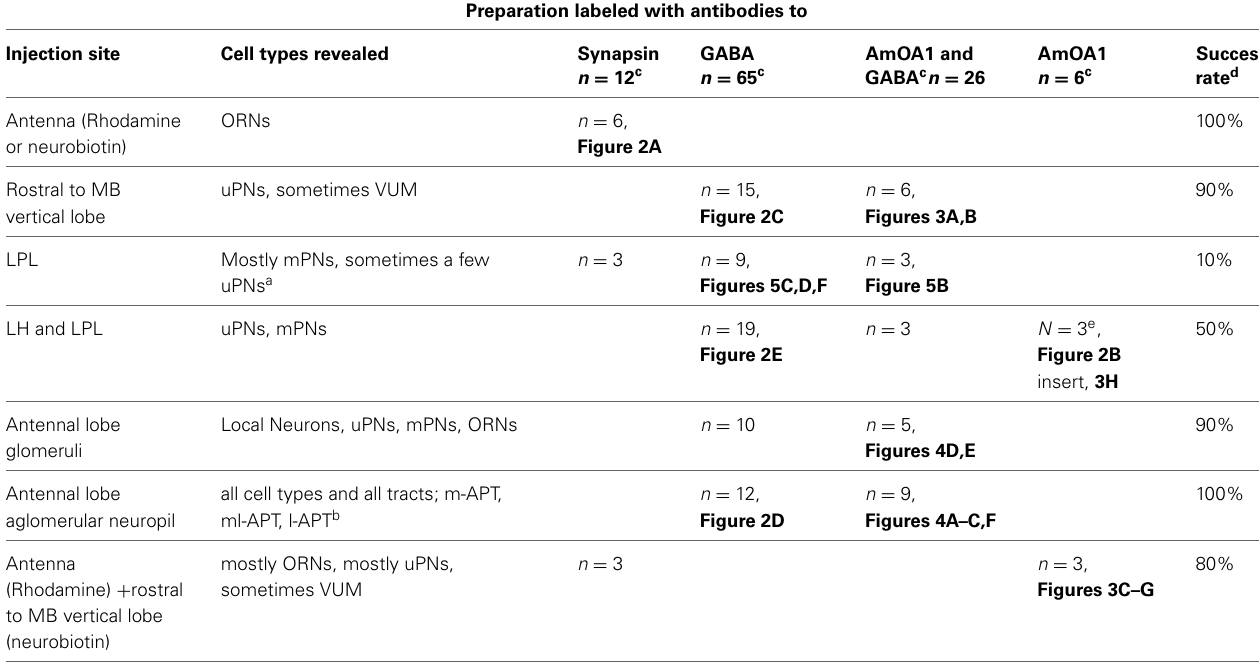
Table 1 | Summary of all preparations used in this